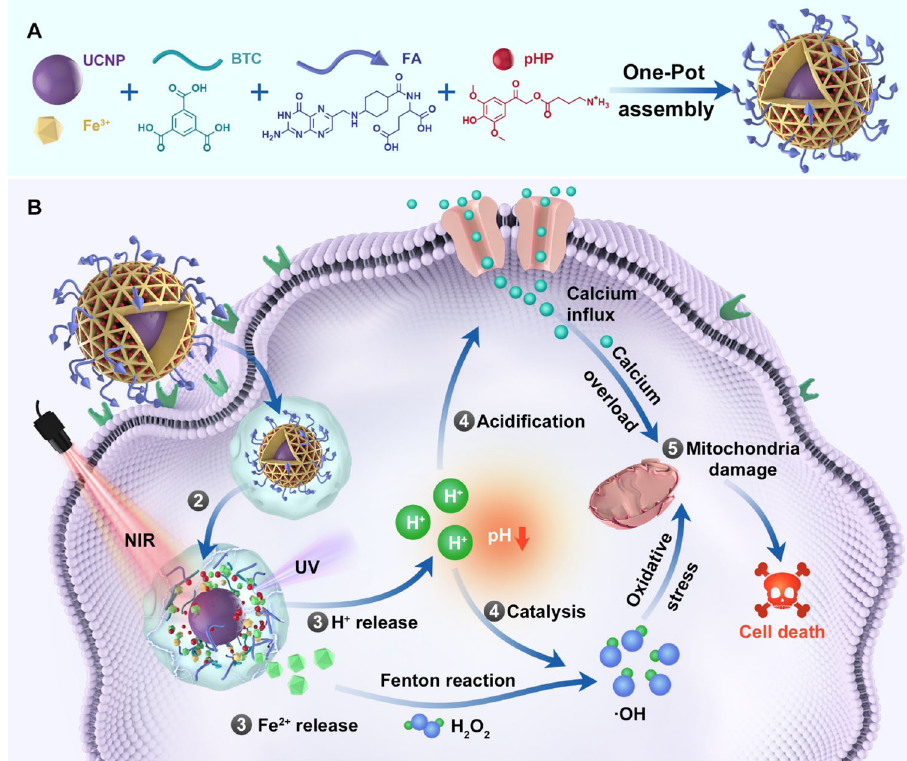
Fig. 1 Schematic Illustration of the construction of FMUP nanoagent and the underlying anticancer mechanism. A Core – shell type FMUP nanoagents with UCNP as the core and photoacid (pHP) encapsulated in the cavity of FA-doped MOFs shell were constructed by one-pot self-assembly. The FMUP nanoagent was synthesized by coordination of carboxyl groups on BTC and FA with Fe 3 + . The UCNP as the core was located in the shell and simultaneously the pHP was loaded in the pore of the nanoagent. B Corresponding anticancer mechanism of FMUP nanoagent. ① Active internalization of FMUP in tumor cells helped by FA functionalization. ② Lysosome escape of FMUP induced by the increase of osmotic pressure after NIR light irradiation. ③ Fe 2 + and H + release from FMUP upon NIR light irradiation. ④ Photoacidi fi cation of intracellular microenvironment induced calcium in fl ux and therefore calcium overload in the mitochondria and simultaneously generated a key acidic environment for ef fi cient Fenton reactions. The release of Fe 2 +